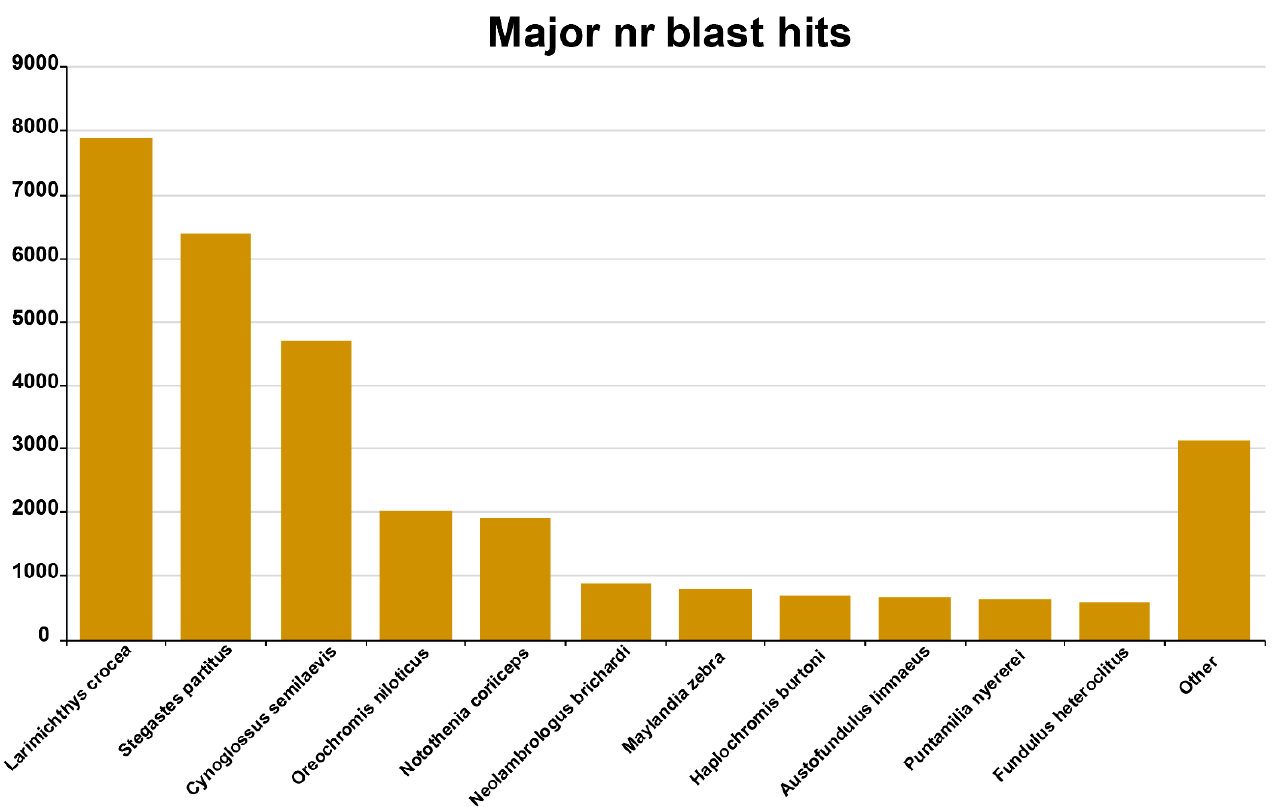
Figure 1. Major nr blast hits. X- axis: number of transcripts blasted. Y- axis: name of species.